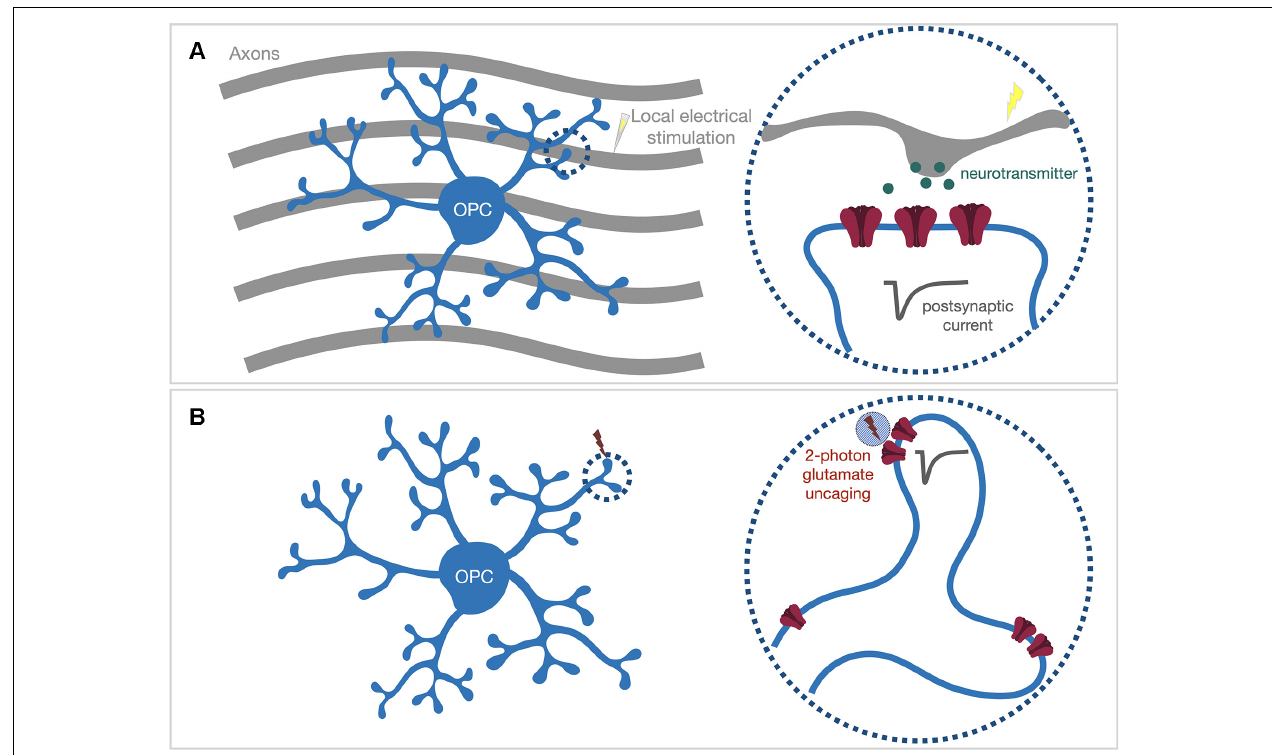
FIGURE 2 | Locally activate postsynaptic receptors within OPC processes via either (A) local electrical stimulation or (B) 2-photon glutamate uncaging. (A) The mono-polar stimulating electrode can be placed in close proximity ( ∼ 5 µ m) to the target OPC process (dash circle) to only stimulate the axons passing the process segment. (B) Acute brain slices are bathed with caged-glutamate containing bath solution. The 2-photon uncaging laser ( ∼ 720 nm) is pointed to the target locations by galvo scan mirrors inside the scan head. A brief uncaging laser pulse (0.6–1 ms) will uncage the caged-glutamate compound within the 2-photon excitation volume (blue shaded circle) and evoke an electrical response from post-synaptic neurotransmitter receptors (dark gray